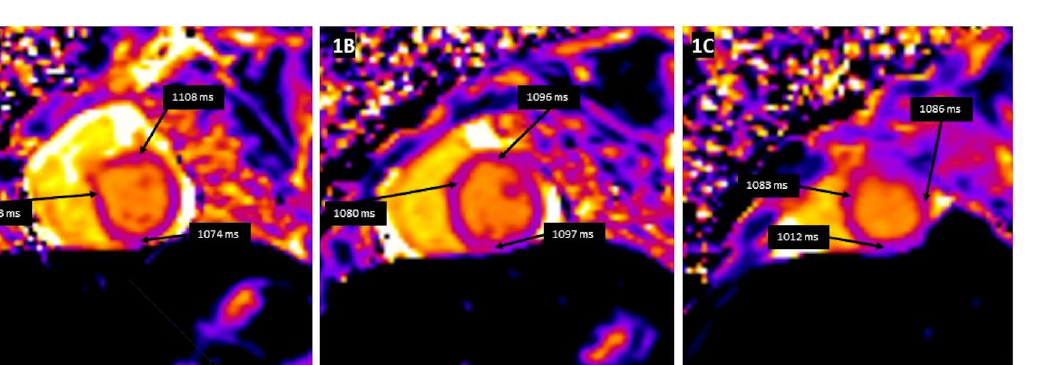
Figure 2. T2 mapping demonstrating the regional increase in myocardial T2 relaxation times at the basal anteroseptal and anterolateral segments ( A ), with normal T2 times at the mid-ventricular level ( B ) and the apex ( C ). Clinical vignette: A 20-month-old female with myocarditis associated with rhino/enterovirus, rapid left ventricular ejection fraction recovery from 24% to 48%, elevated tro- ponin, and diffuse low voltage QRS complexes on electrocardiogram. There was no evidence of myocardial delayed enhancement after gadolinium contrast emphasizing the additional utility of T1 and T2 mapping in the evaluation of myocarditis. The diagnostic CMR criteria are derived from the common consensus among experts (Lake Louise Consensus (LLC) criteria) for myocarditis in adults [16]. The hallmark fea- tures of myocardial inflammation on CMR are (1) T2-weighted imaging, which assesses for edema; (2) T1-weighted early gadolinium enhancement imaging (EGE), which assesses for hyperemia; and (3) LGE, which assesses for myocyte necrosis and scar. The CMR LLC criteria seem to have moderate accuracy in diagnosing acute myocarditis [17,18]. LLC cri- teria are qualitative analyses and rely upon the increased signal intensity of the myocar- dium relative to the normal myocardium. These criteria, therefore, have limited applica- bility for diffuse myocardial involvement without focal findings. Subsequently, a revised version of the LLC was released in 2018 with quantitative tissue mapping techniques. Ac- cording to the updated LLC criteria, myocarditis can be diagnosed with high specificity based on: (i) the presence of one of the T2-based criteria (i.e., regional or global increase in T2 relaxation time or increased signal intensity on T2 weighted images) and (ii) the presence of one T1-based criterion out of three: prolonged T1 relaxation time, elevated ECV or LGE [19]. Both criteria have a reported median area under the curve for detecting myocarditis ranging from 0.75 to 0.90. Either isolated T1- or T2-based criteria in the ap- propriate clinical setting can suggest myocardial inflammation in adults [19,20]. It is im- portant to note that the LLC criteria have not been validated in children.